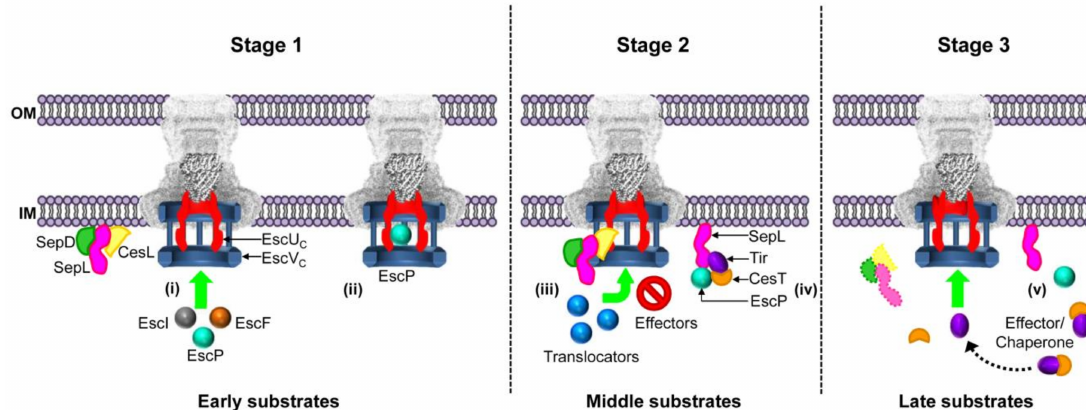
Figure 7. Model for regulation of type III secretion hierarchy. During T3SS assembly, two molecular switches ensure that the different substrates are secreted in a hierarchical order. Stage 1. ( i ) Early substrates are secreted. At this time, the molecular switch proteins SepL, SepD and CesL (in complex or independently), are associated with the membrane and likely located near the export apparatus. ( ii ) When the needle reaches its predetermined length, EscP interacts with EscU C , promoting a conformational change that flips the first substrate specificity switch, thereby halting early substrate secretion and allowing (together with the SepL/SepD/CesL complex) middle substrate recognition (see next stage). Stage 2. ( iii ) The first specificity switching event is transmitted to the EscV export gate component via interactions of the SepL/SepD/CesL heterotrimeric complex with both EscU and EscV. This communication enables middle substrates to be recognized and secreted by the EscV docking platform. ( iv ) At the same time, EscP bound to SepL sequesters the chaperone-effector CesT/Tir complex. Stage 3. ( v ) Once the translocation pore has been inserted into the host cell membrane, an activation signal is transmitted to the export apparatus, which results in switch complex dissociation, permitting late substrates binding to EscV and effector translocation. In addition, it has been shown that a drop in calcium concentration dissociates the SepL–EscP interaction, releasing the CesT/Tir complex for docking at